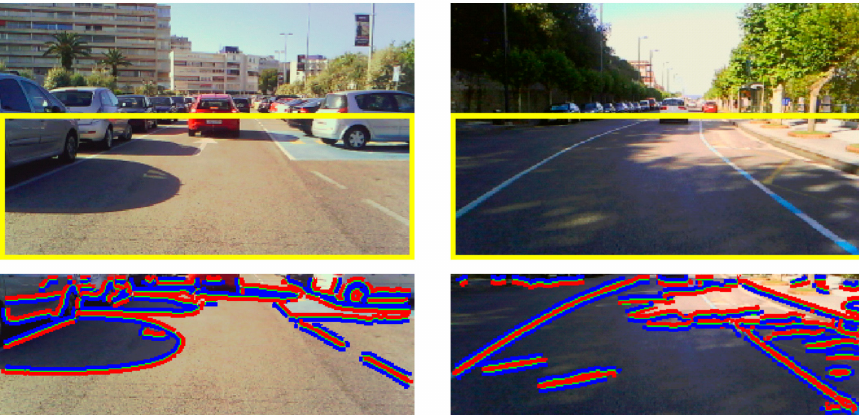
Figure 2. ( First row ) Bounding box containing the region of interest (ROI) of two input red–green–blue (RGB) images of our dataset. ( Second row ) Darker (in blue) and brighter (in red) regions on both sides of each edge (in green) of the ROI image.